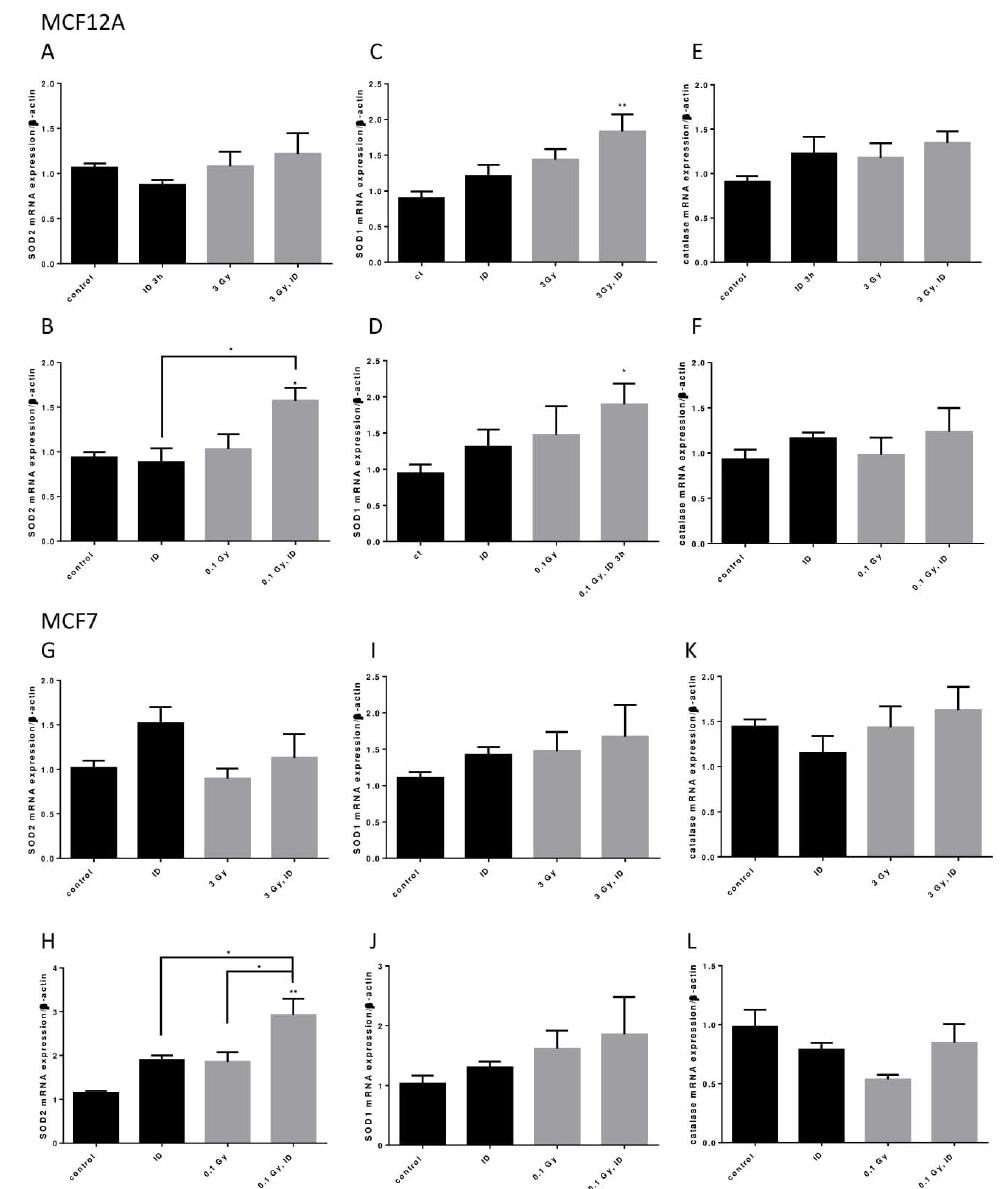
Figure 8. ID and radiation additively up-regulate antioxidant enzymes mRNA in breast cells. Cells were cultured in iodine-containing medium for 7 days. Medium was replaced by iodine-containing (control) or iodine deficient (ID) medium and cells were then irradiated with a dose of 0.1 or 3 Gy. Cells were harvested 3 (MCF12A) or 6 (MCF7) hours after medium change. SOD1, SOD2, and catalase mRNA expression in MCF12A ( A – F ) and MCF7 cells ( G – L ) was determined using RT-qPCR. Data are expressed as means ± SEM. p -value < 0.05 were considered as statistically significant. * p < 0.05, ** p < 0.01. Statistical test: one-way ANOVA with Tukey post-hoc test. A: N = 6; B, G: N = 4; C, D, F, K: N = 5; E: N = 8; H, I, J, L: N = 3.